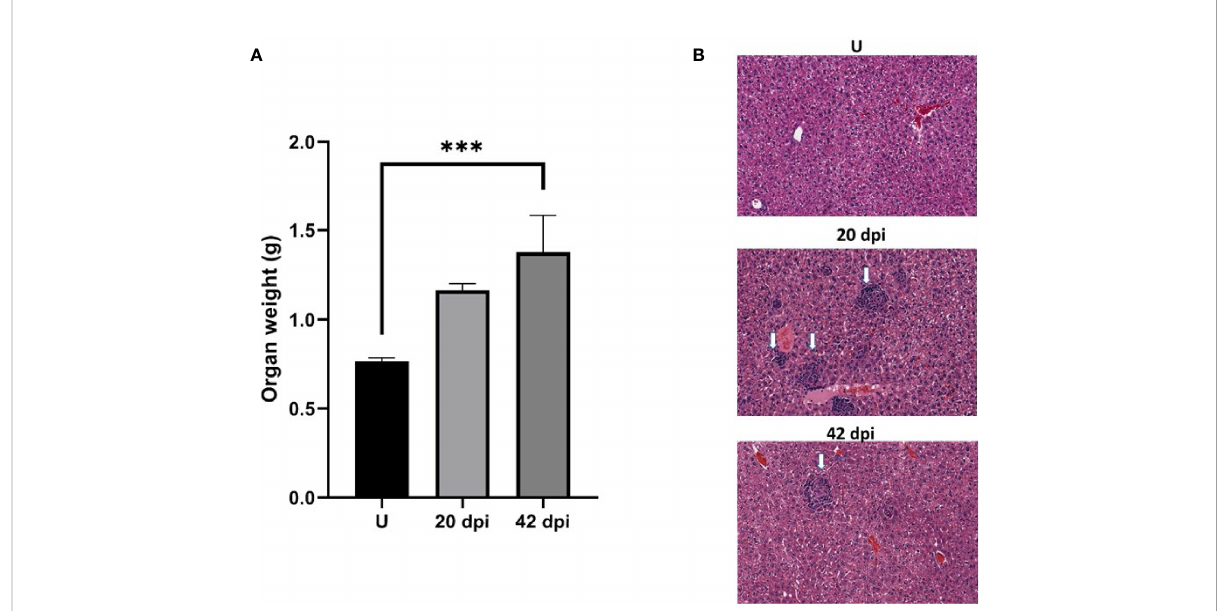
FIGURE 1 The course of L. donovani infection in BALB/c mice. Mice were infected by tail vein injection with metacyclic promastigote forms. Mice were sacri fi ced after 20 or 42 days. The liver was recovered and weighed before formalin fi xation. (A) Plot of liver weights. (B) Representative H&E sections of liver tissue that was paraf fi n-embedded and processed for histochemical analyses. White arrows point to granulomas. Each group was composed of 3 animals. *** denotes statistically signi fi cant difference p<0.005. Experimental L. donovani infections wereperformed 2